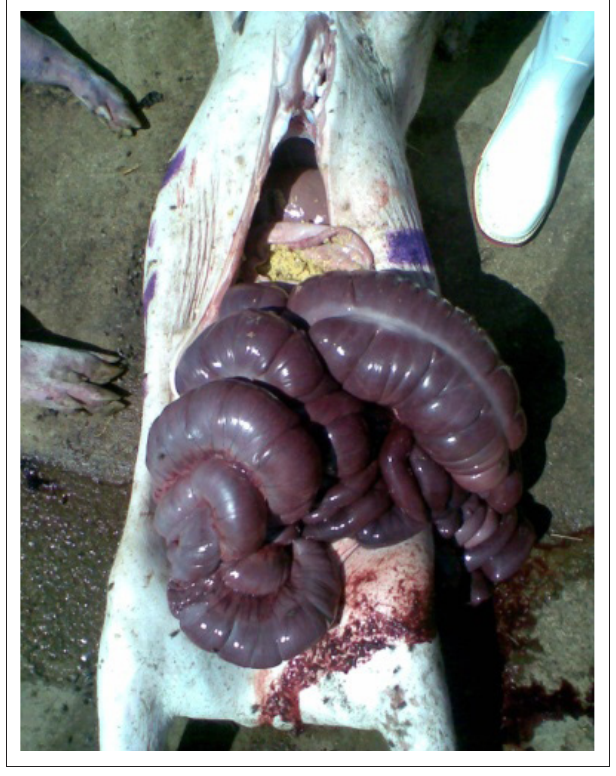
FIGURE 2: Severely distended and discoloured intestines in one of the pigs in this